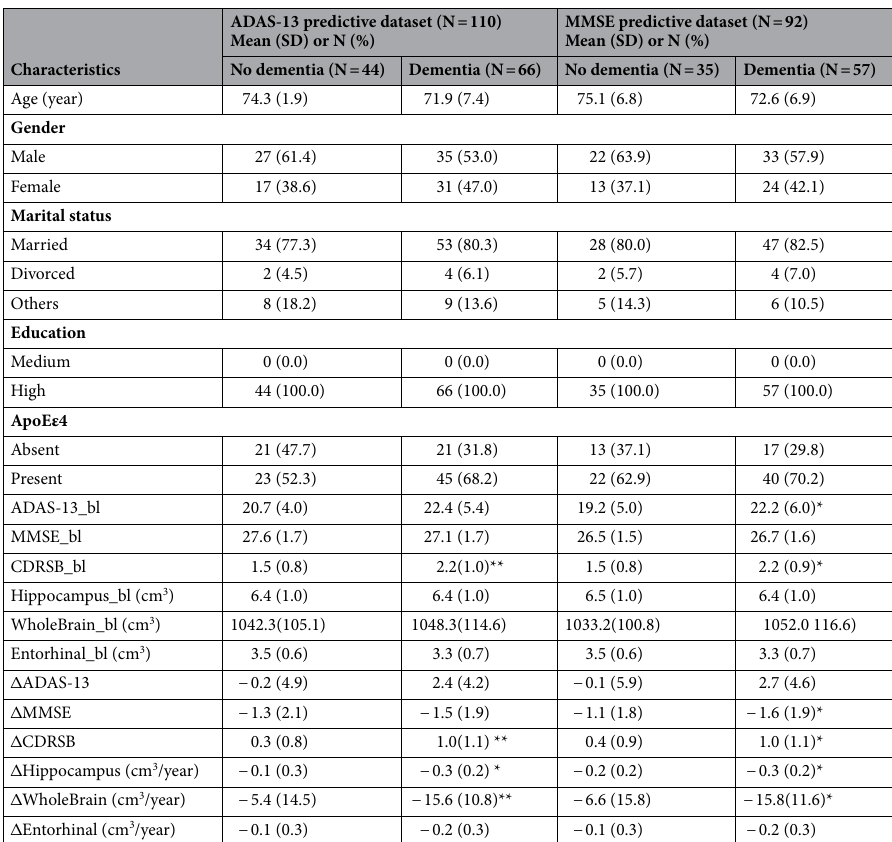
Table 2. Predictors of high-risk patients with MCI based on ADAS-13 (N = 110) and MMSE (N = 92) predictive datasets, stratified by dementia status over 3 years of follow-up. ADAS-13_bl, Alzheimer